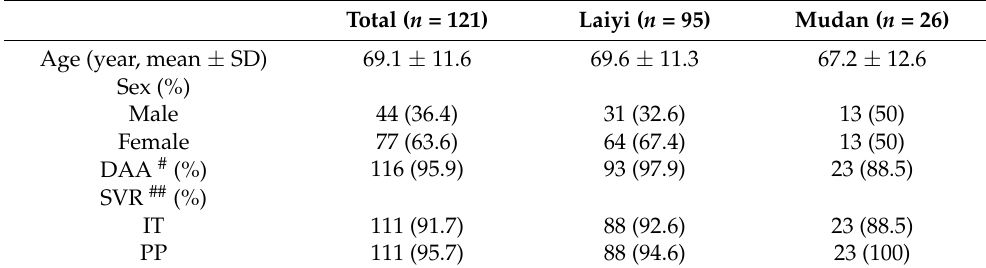
Table 3. Demographics of hepatitis C viremia patients and effect of direct acting antivirals (DAA) in outreach hepatology